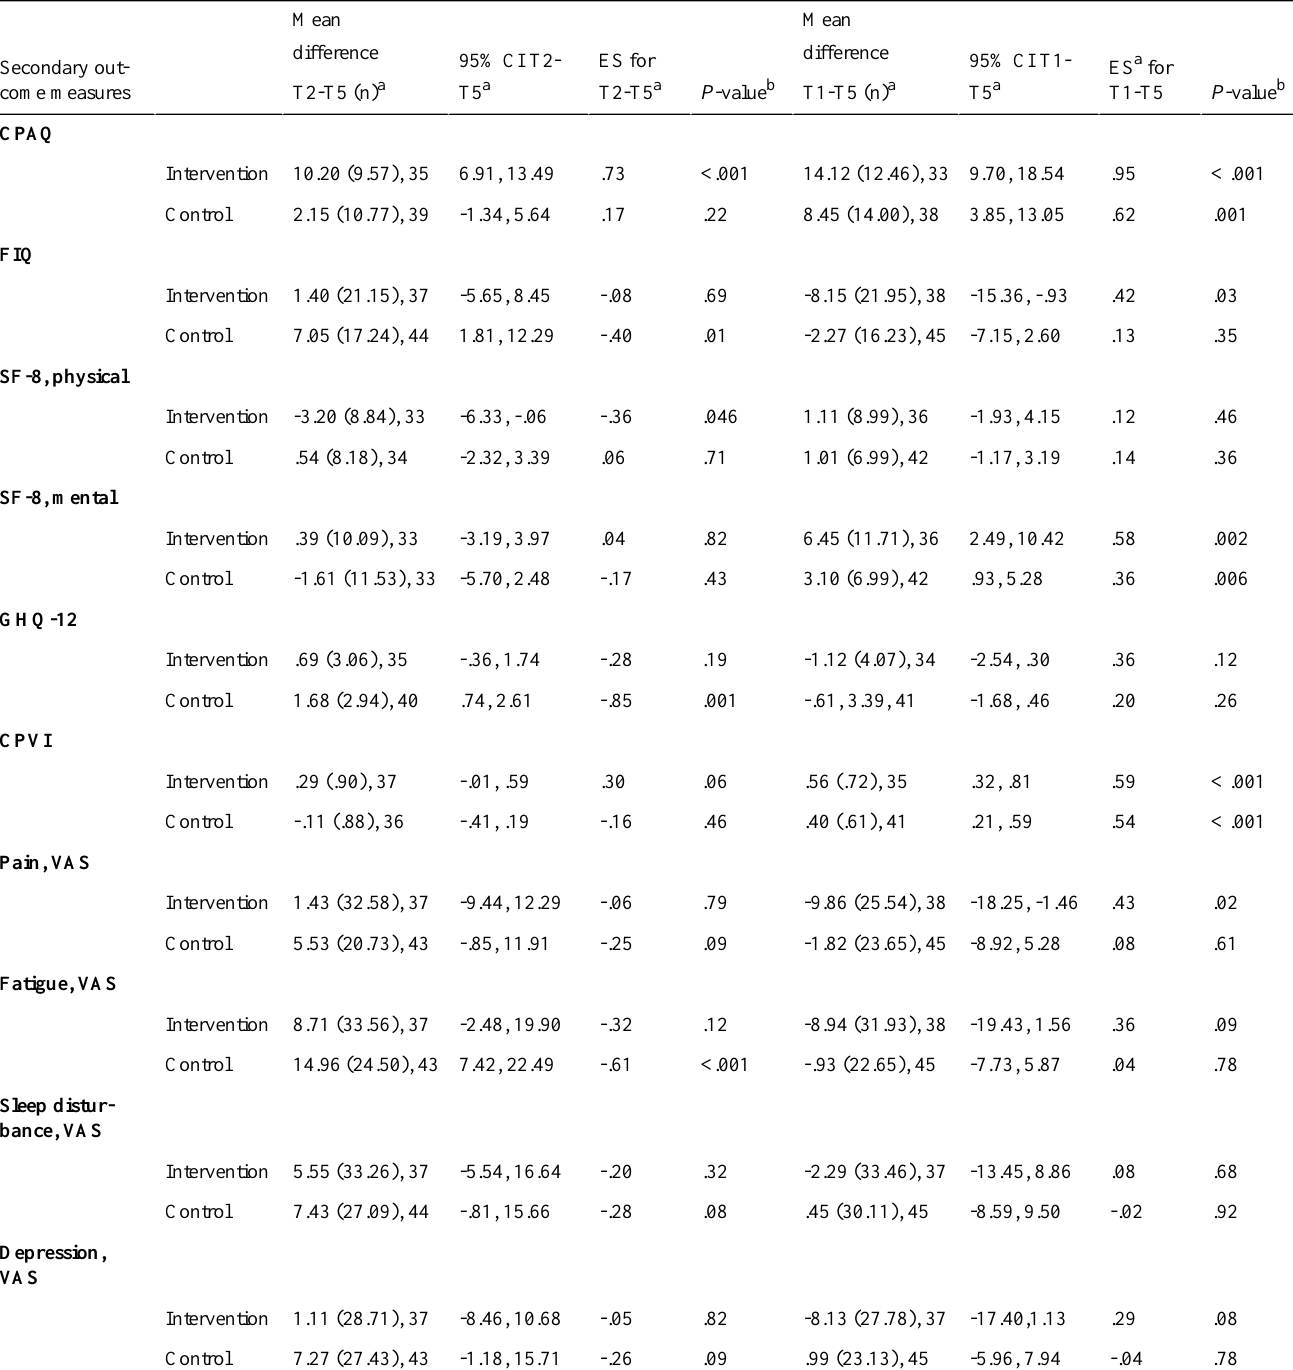
Table 5. Mean differences for the secondary outcomes within-groups, confidence intervals (CI) and effect sizes (ES) for the